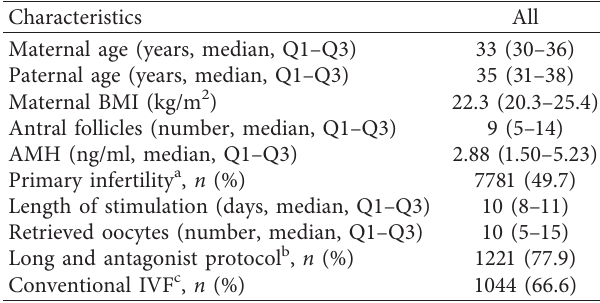
Figure 1: Flow chart of selection of 1568 patients with 10941 embryos. Table 1: Demographic and treatment cycle characteristics of all participants ( n �